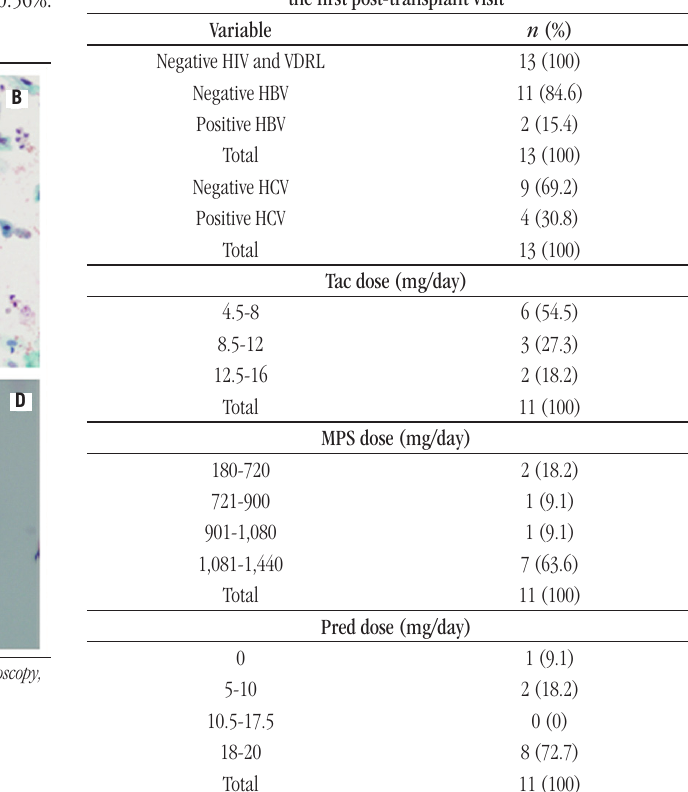
taBLE 1 − Patients’ profiles as to pre-transplant STDs and immune status